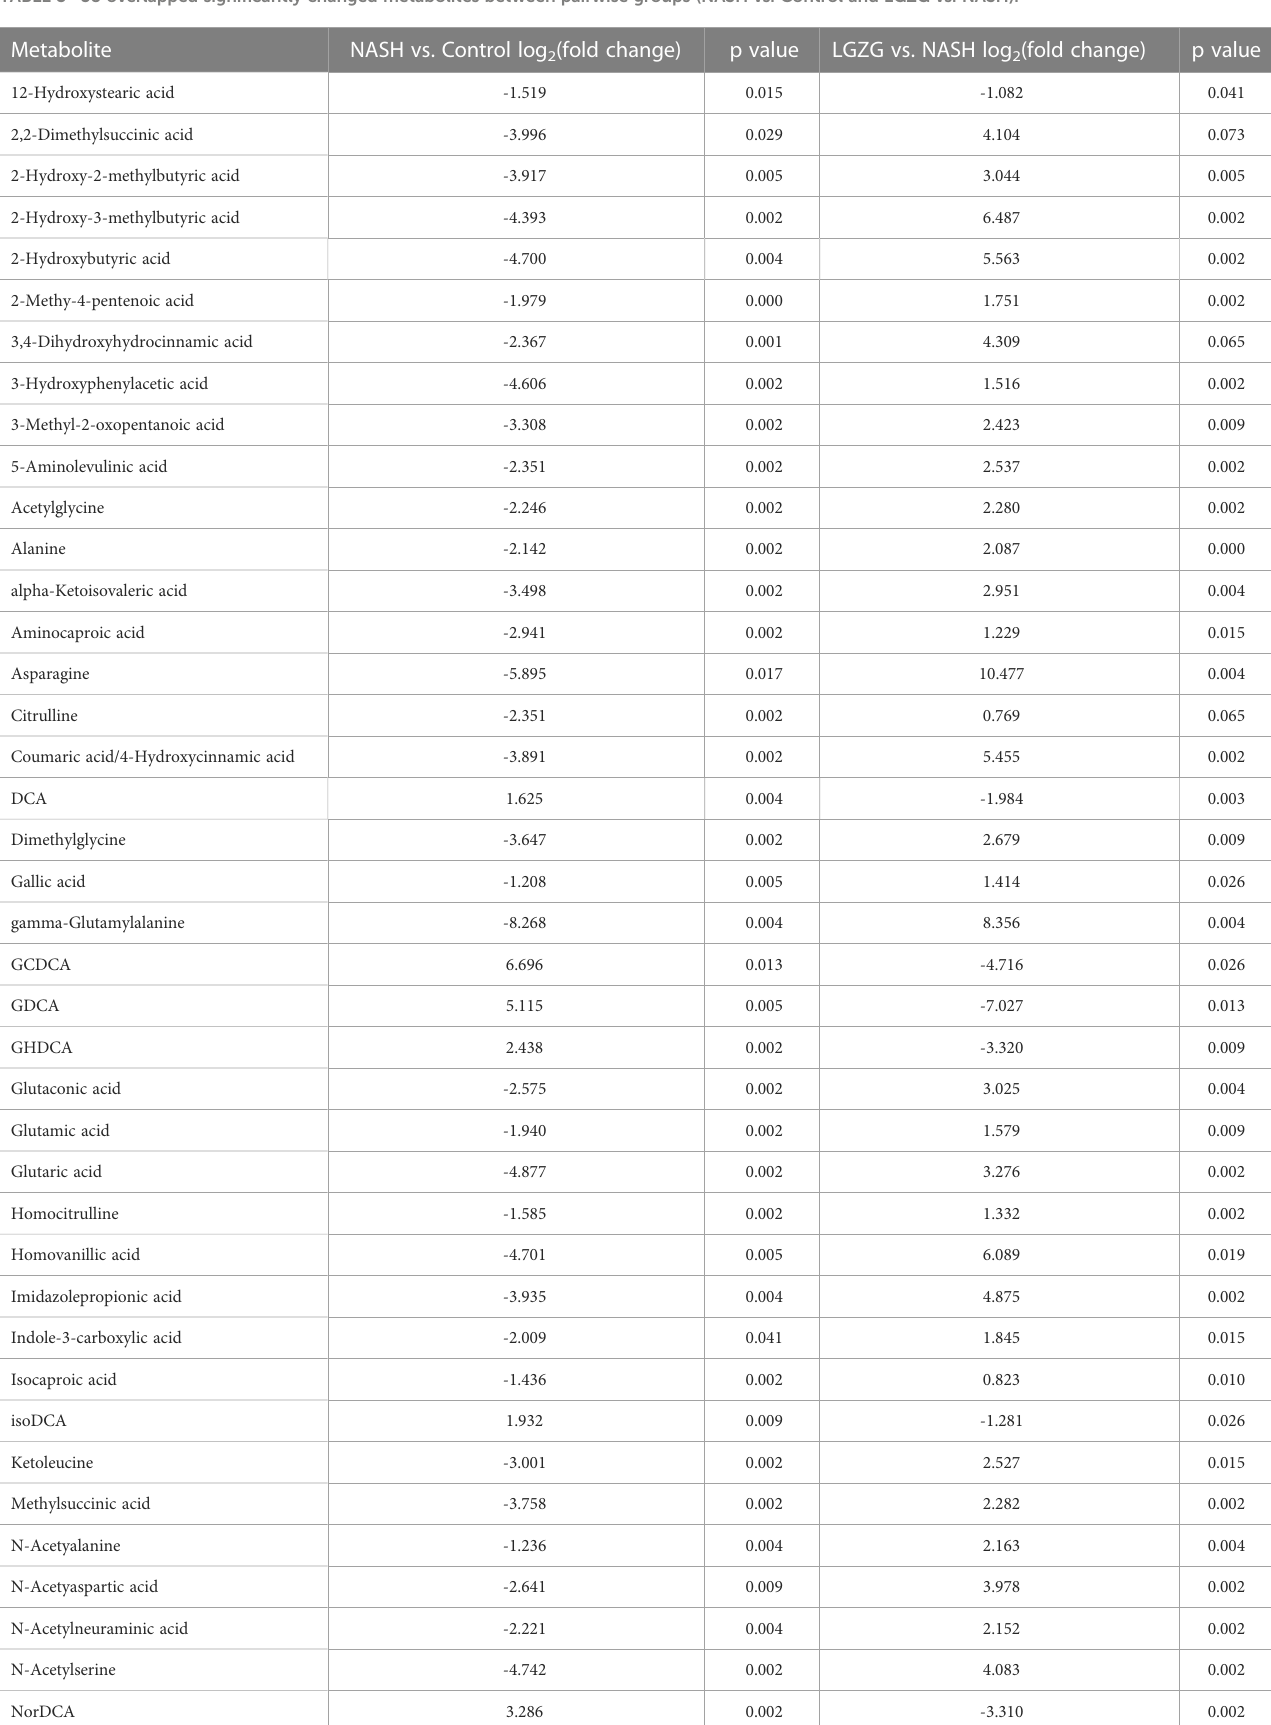
TABLE 3 58 overlapped signi fi cantly changed metabolites between pairwise groups (NASH vs. Control and LGZG vs.